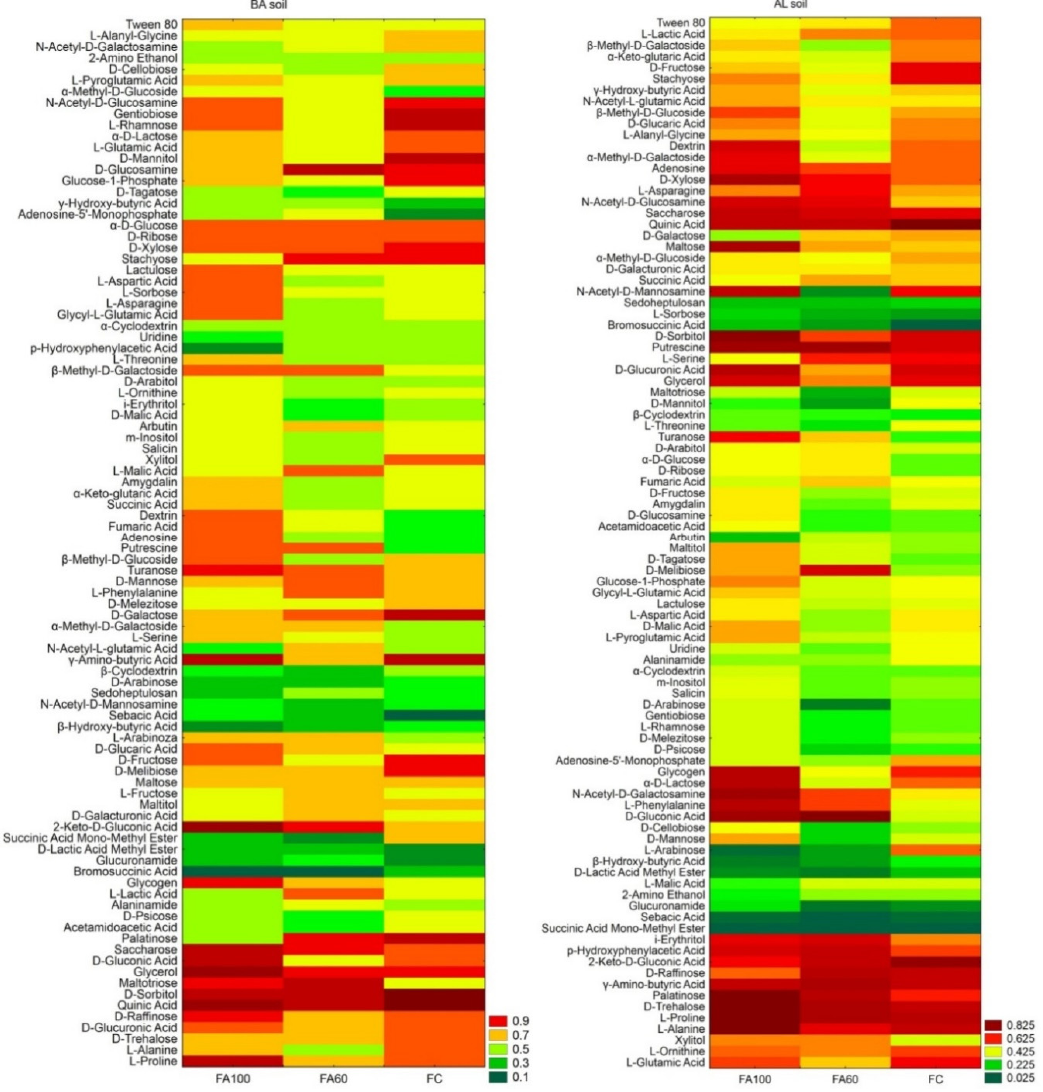
Figure 3. Diagrams of fungal growth intensity on the BIOLOG FF TM plate carbon substrates. Explanation: BA—Brunic Arenosol, AL—Abruptic Luvisol, FC—optimal dose of fertilizer, FA100—optimal dose of fertilizer enriched with microorganisms, FA60—fertilizer enriched with microorganisms (dose reduced by